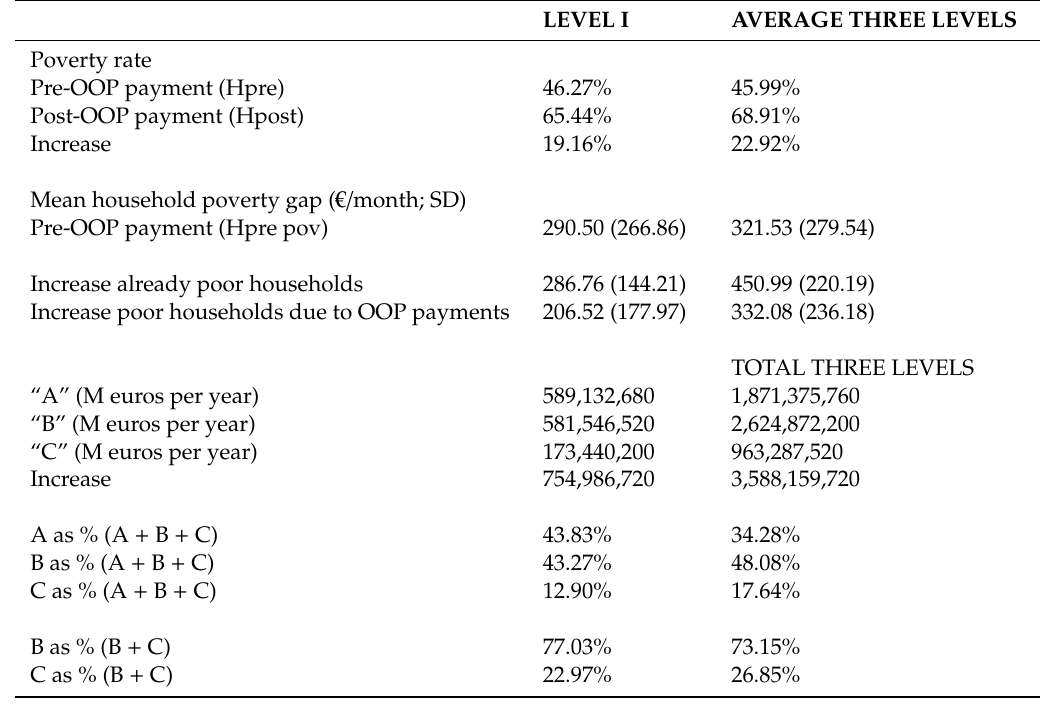
Table 7. Impoverishment rate of dependent care OOP payments by level. Scenario 2 (complete application, including levels I, II, and